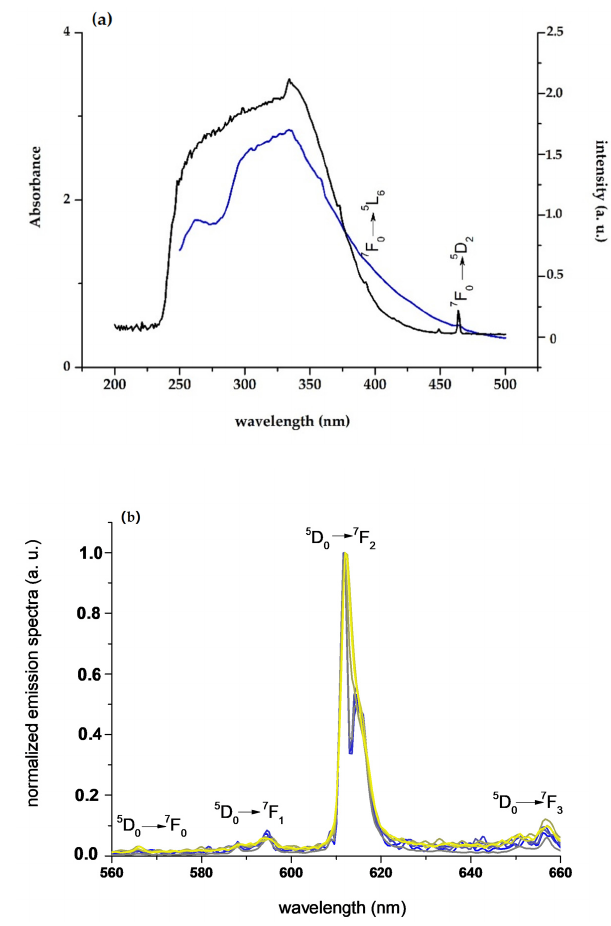
Figure 3. ( a ) Absorption spectra of 1 (blue line) and excitation spectra (black line) monitored with λ em = 612 nm. ( b ) Normalized emission spectra of 1 relative to the maximum of 5 D 0 → 7 F 2 transition band (25 °C), from 25 (blue line) to 55 °C (yellow line) with a 5 °C·min − 1 step size between each measurement with λ exc. = 345 nm.